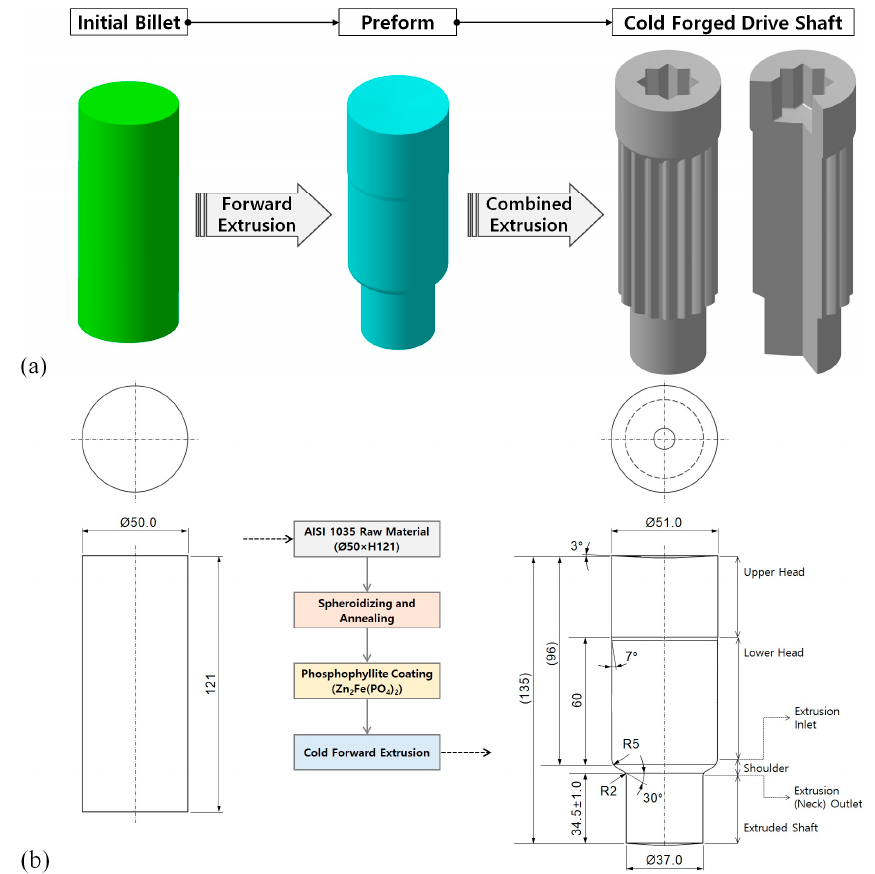
Figure 1. Schematic illustrations of ( a ) the overall process flow for manufacturing a drive shaft, and ( b ) a detailed flowchart for fabricating preform (unit: mm).